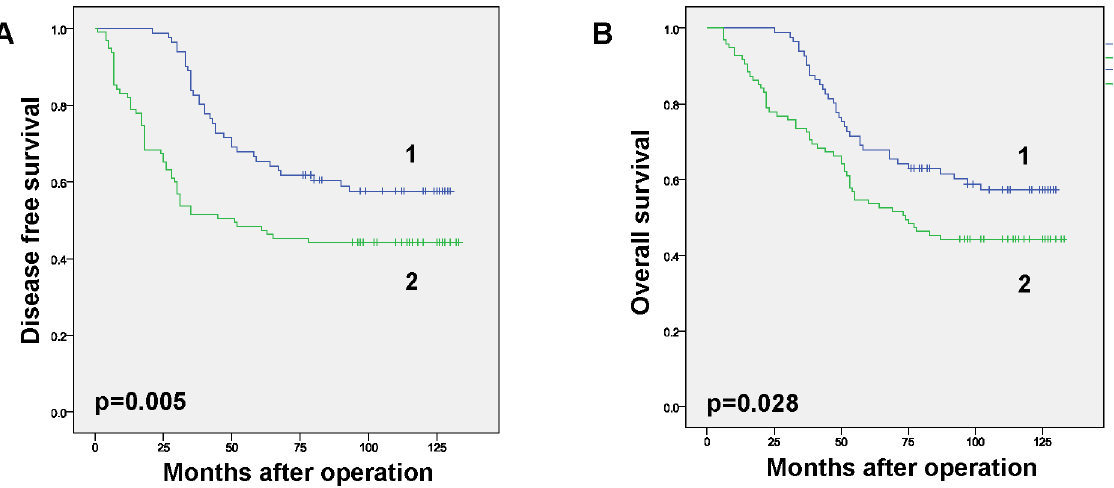
Figure 3. Survival analysis of breast cancer patients with different PKC f levels. Survival status of patients was tracked for 132 months post- operatively. 1, low expression group; 2, high expression group. The survival statistical analysis was concluded by SPSS method. Survival curves were obtained using the Kaplan-Meier method. Differences in survival curves were assessed according to the log rank test. Differences were considered significant at values of P , 0.05. A) Disease-free survival plot. B) Overall survival plot. Survival rates were calculated and obtained using SPSS software.